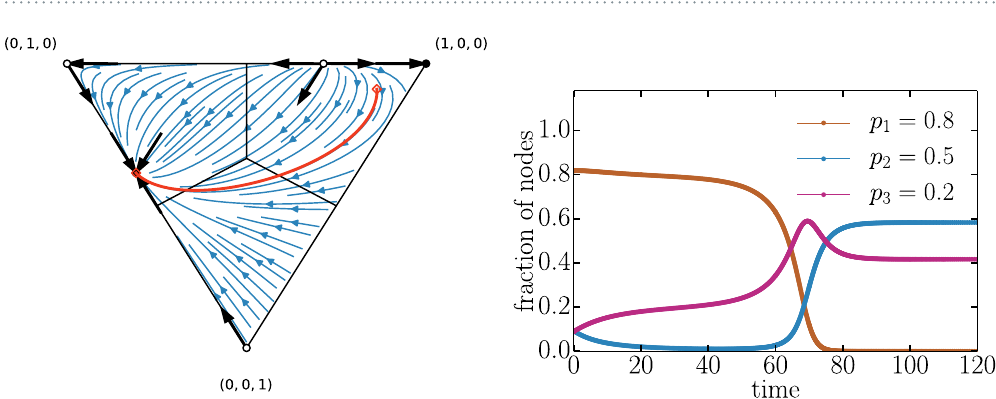
Figure 5. Long transient behavior with mixed strategies. (left) We compute the flow diagram using p 1 = 0.8, p 2 = 0.5 and p 3 = 0.2. Notice that the pairwise competition of competitor 1 and 3 leads to a line of fixed points on the right edge of the simplex because of the pathological case p 1 = 1 − p 3 , see Supplementary Methods for details. (right) Example of a time series where the final winner ( p 2 ) stays close to extinction until competitor 3 obtains a